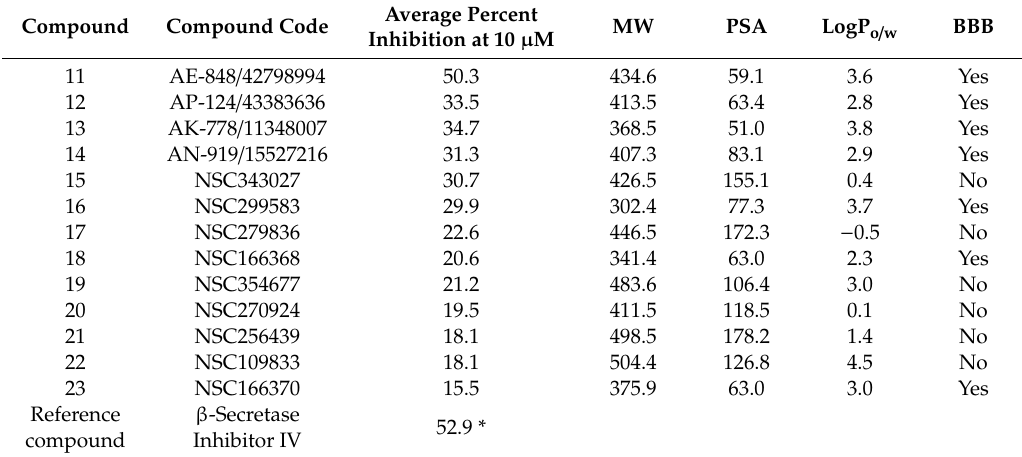
(logP o / w ) polar surface area (PSA), and the prediction of (blood–brain barrier) BBB